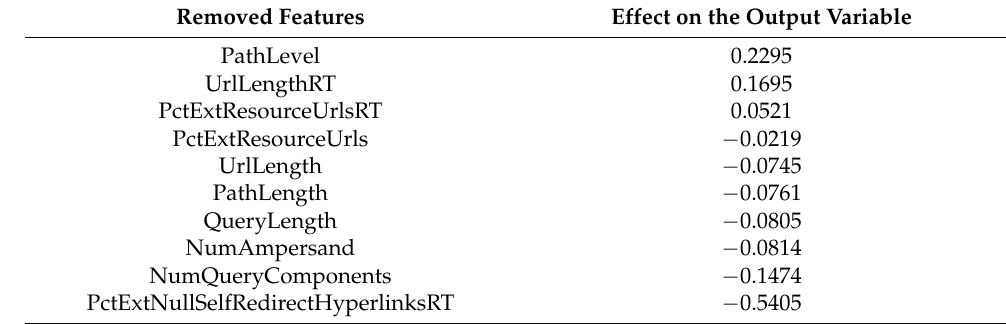
Table 9. List of removed features using MICe TICe and their effect on the output variable on dataset